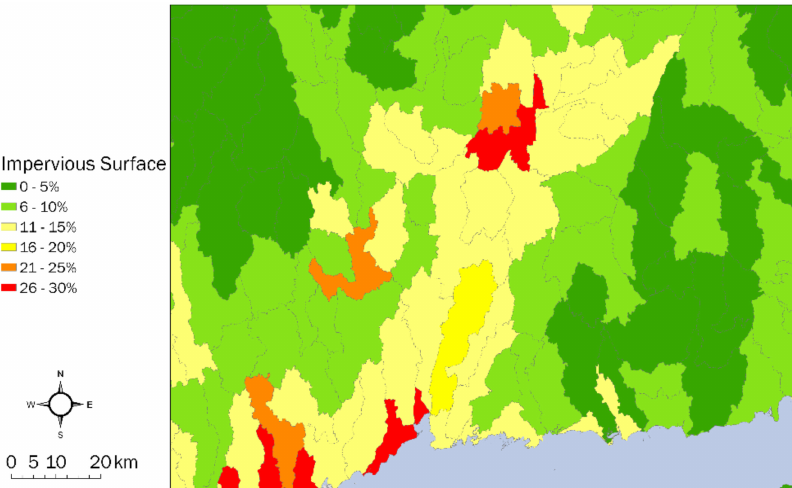
Figure 5. Central shoreline of Connecticut showing results of Impervious Surface Analysis Tool (ISAT) model by Hydrologic Unit Code (HUC)-12